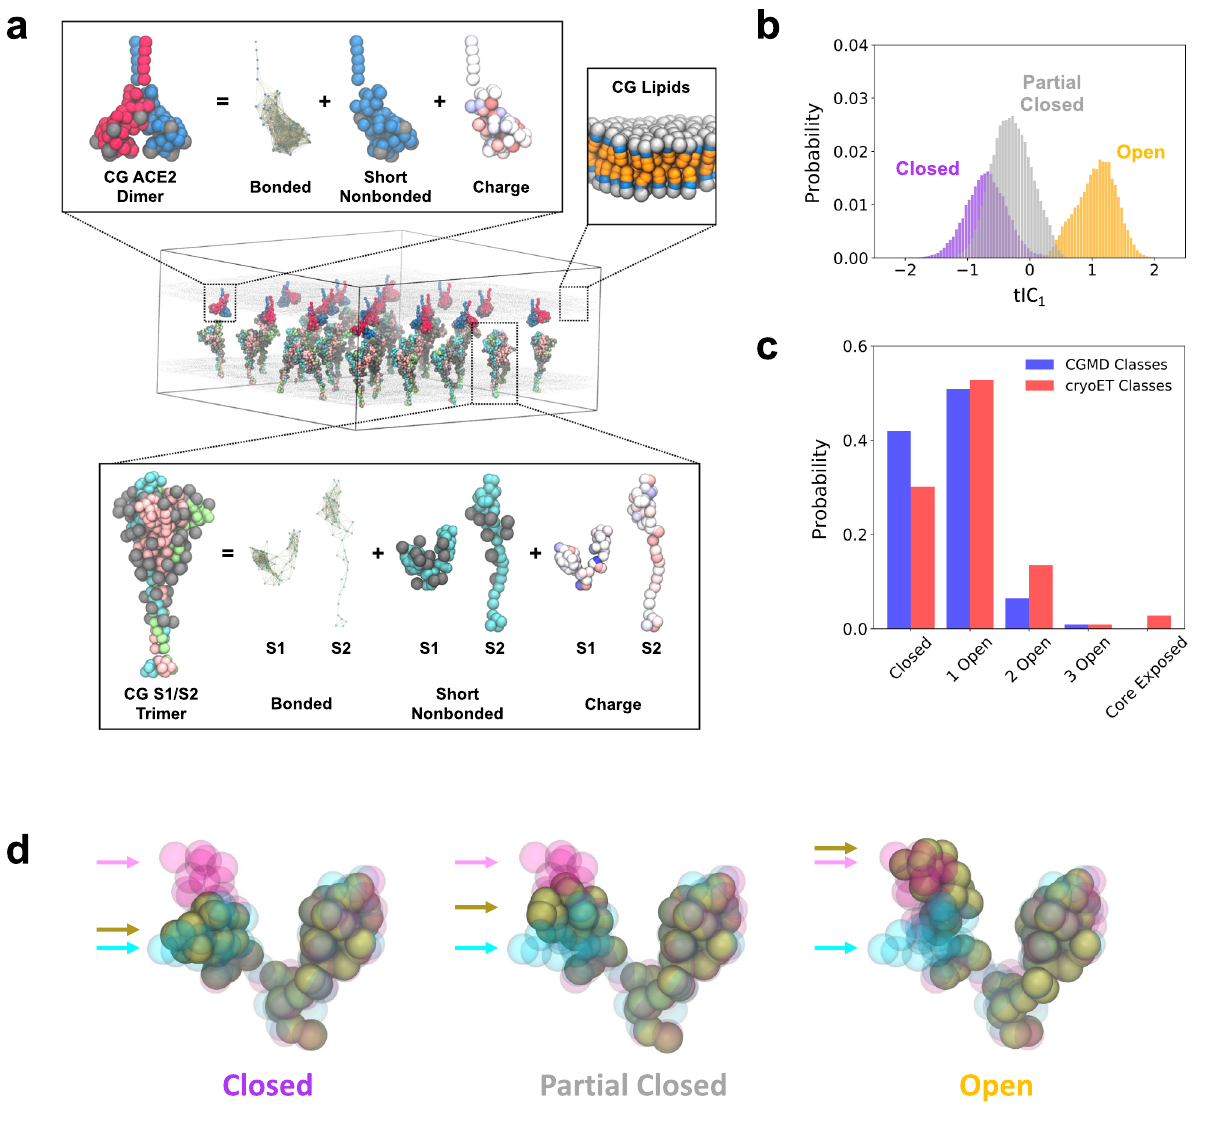
Fig. 1 Schematic overview and characterization of our coarse-grained (CG) models. a Representative depiction of a CG simulation of spike trimers in membrane interacting with an adjacent membrane with ACE2 dimers. The insets depict the CG model components for the spike trimer (bottom), ACE2 dimer (upper left), and lipid membrane (upper right). Note that the protein CG sites are colored by monomer while glycans are represented by gray balls. b Probability distributions for RBD conformations projected onto the fi rst time-lagged independent component (tIC 1 ). The purple, gray, and orange distributions ( N = 19383, 33810, and 21810, respectively) denote the three clusters identi fi ed by k-means clustering with labels indicating their representative conformational state. c Comparison of spike trimer conformational state populations (ranging from 0 to 3 open RBDs or shed RBDs, i.e., exposure of the S2 trimeric core) from CG simulations ( N = 53076) and cryo-ET classi fi cation ( N = 4220); the core exposed state is in the prefusion form in the CG simulations while it is in the postfusion form in the cryo-ET dataset. d Representative depiction of the average con fi guration of CG S1 (brown beads) within the identi fi ed k-means clusters. For reference, CG con fi gurations of experimentally-resolved open and closed states of S1 are shown as magenta and cyan beads, respectively. Arrows indicate the positions of each respective RBDs. In all cases, the N-terminal domains of S1 are (tICA), a linear projection technique that aims to maximize closed con fi gurational states throughout the trimer 2,3,6,7 . There- fore, to validate our updated CG spike model, we quanti fi ed the con fi gurational sampling of the RBD. We fi rst simulated a single CG spike trimer in membrane (see “ Methods ” ) for 50 × 10 6 CG timesteps ( τ CG = 50 fs). To characterize the motions of the RBD, we quanti fi ed the distribution of reciprocal interatomic distances 32 (DRID) for each con fi guration of the three RBDs; (tIC 1 ) dimension. Assessing the root-mean-squared deviation of the DRID method computes the fi rst, second, and third moments the con fi gurations from each of the three states (see Fig. 1d and of the reciprocal distances between each CG site and every other Supplementary Fig. 2) reveals that the purple-labeled distribution CG site, yielding 3 N CG features. We next performed dimensional represents “ closed ” RBDs, the orange-labeled distribution repre- reduction using time-lagged independent component analysis sents “ open ” RBDs, and the gray-labeled distribution represents